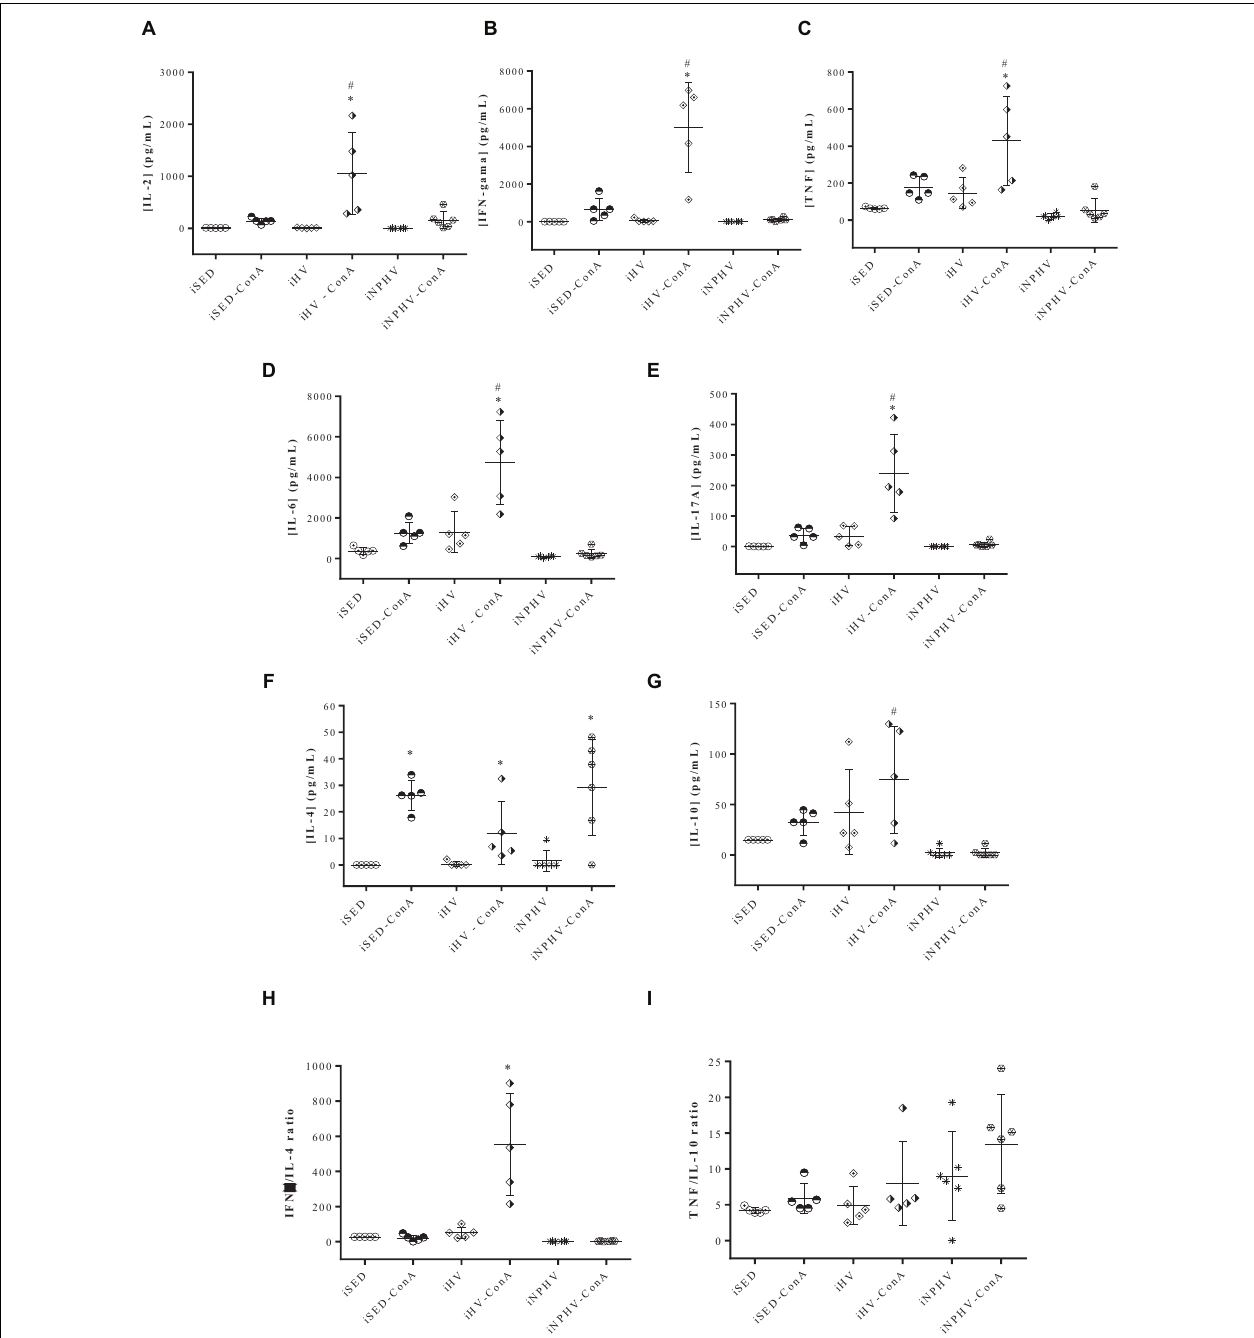
FIGURE 6 | Effect of physical exercise on cytokine production by spleen cells of BALB/c mice. The concentration of cytokines was determined by the CBA method, according to the section “Materials and Methods.” Values represent the mean of two experiments with samples of at least five animals per group, and the bars represent the standard error. (A) IL-2; (B) IFN- γ ; (C) TNF; (D) IL-6; (E) IL-17A; (F) IL-4; (G) IL-10; (H) IFN-g/IL-4 ratio; (I) TNF/IL-10 ratio. ∗ P < 0.005 in relation to its own control without ConA; # P < 0.005 in relation to its iSED group. Groups: infected sedentary control (iSED), infected high volume (iHV), and infected non-periodized high volume (iNPHV). ConA, concanavalin